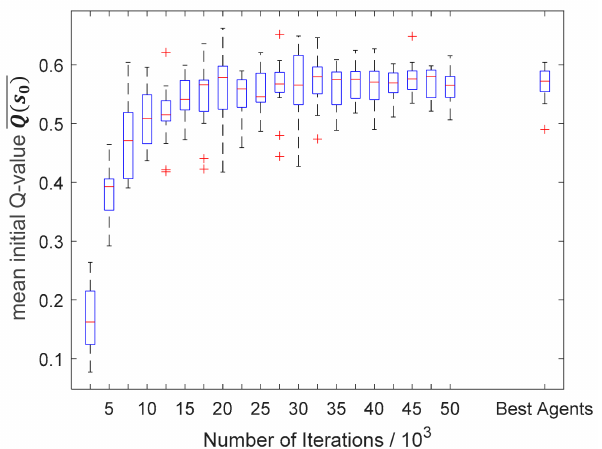
Figure A2. Boxplots of the mean Q-value of the initial state, s 0 , of all 15 trainings over the course of the training process.